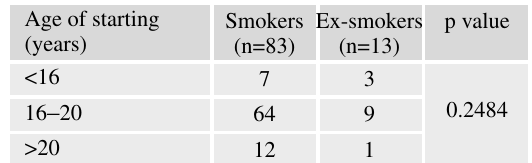
Table II: Distribution of study subjects according Table V: Distribution of study subjects according to presence